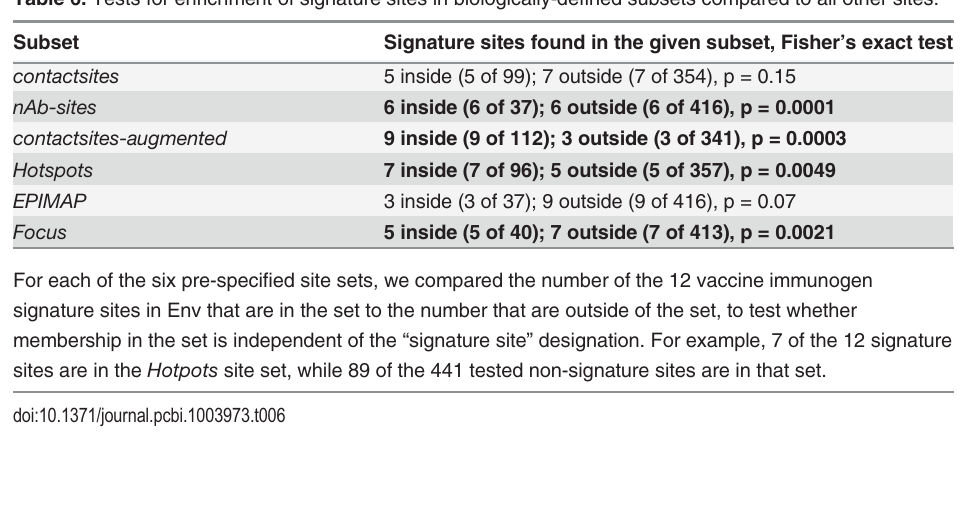
Table 6. Tests for enrichment of signature sites in biologically-de fi ned subsets compared to all other sites. Subset Signature sites found in the given subset, Fisher ’ s exact test